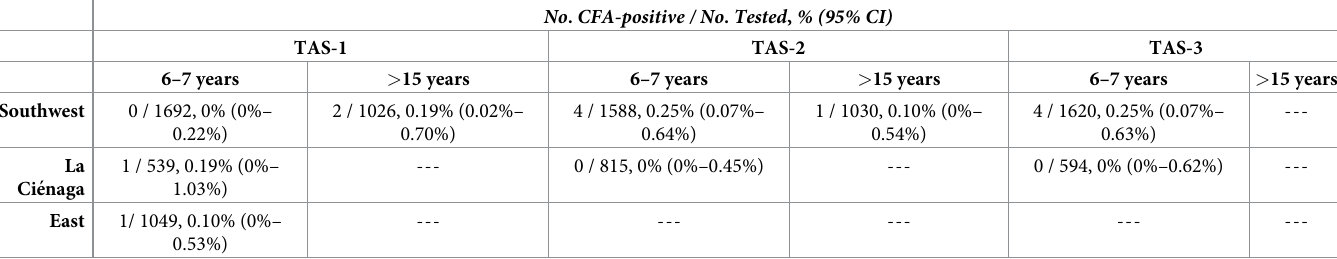
Table 2. Results from transmission assessment surveys (TAS) in the Dominican Republic, by age and by focus